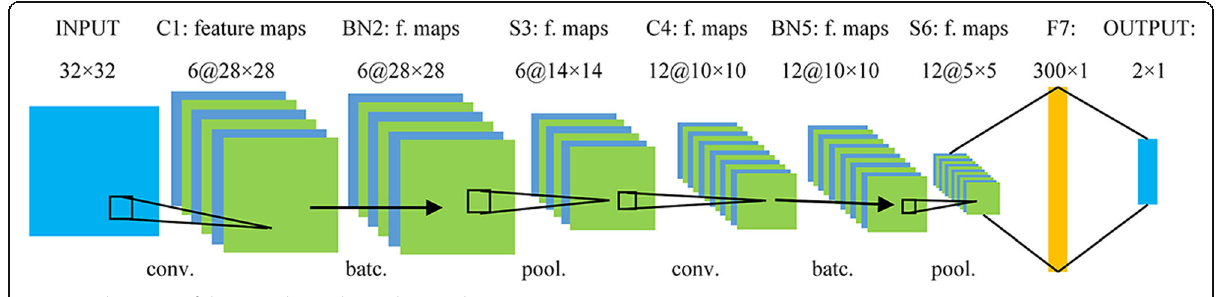
Fig. 2 Architecture of the convolutional neural network